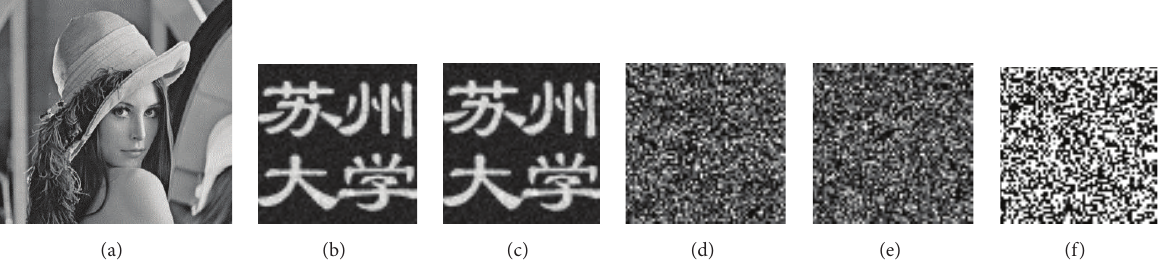
Figure 8: Illustration of the false positive detection. (a) Watermarked image, (b) embedded watermark, (c) extracted watermark with correct information, (d) extracted watermark from (a) by using 𝑉 𝑤 of watermark (WM2), (e) extracted watermark from (a) by using 𝑉 𝑤 of watermark (WM3), and (f) extracted watermark from an arbitrary image by using the information of images given in (a) and